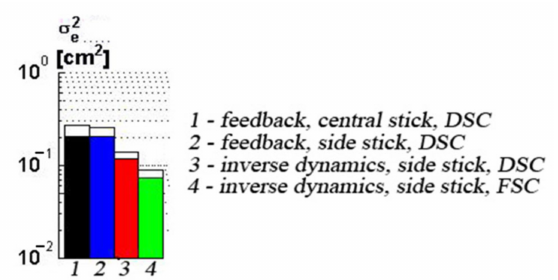
Figure 16. Variance of error.